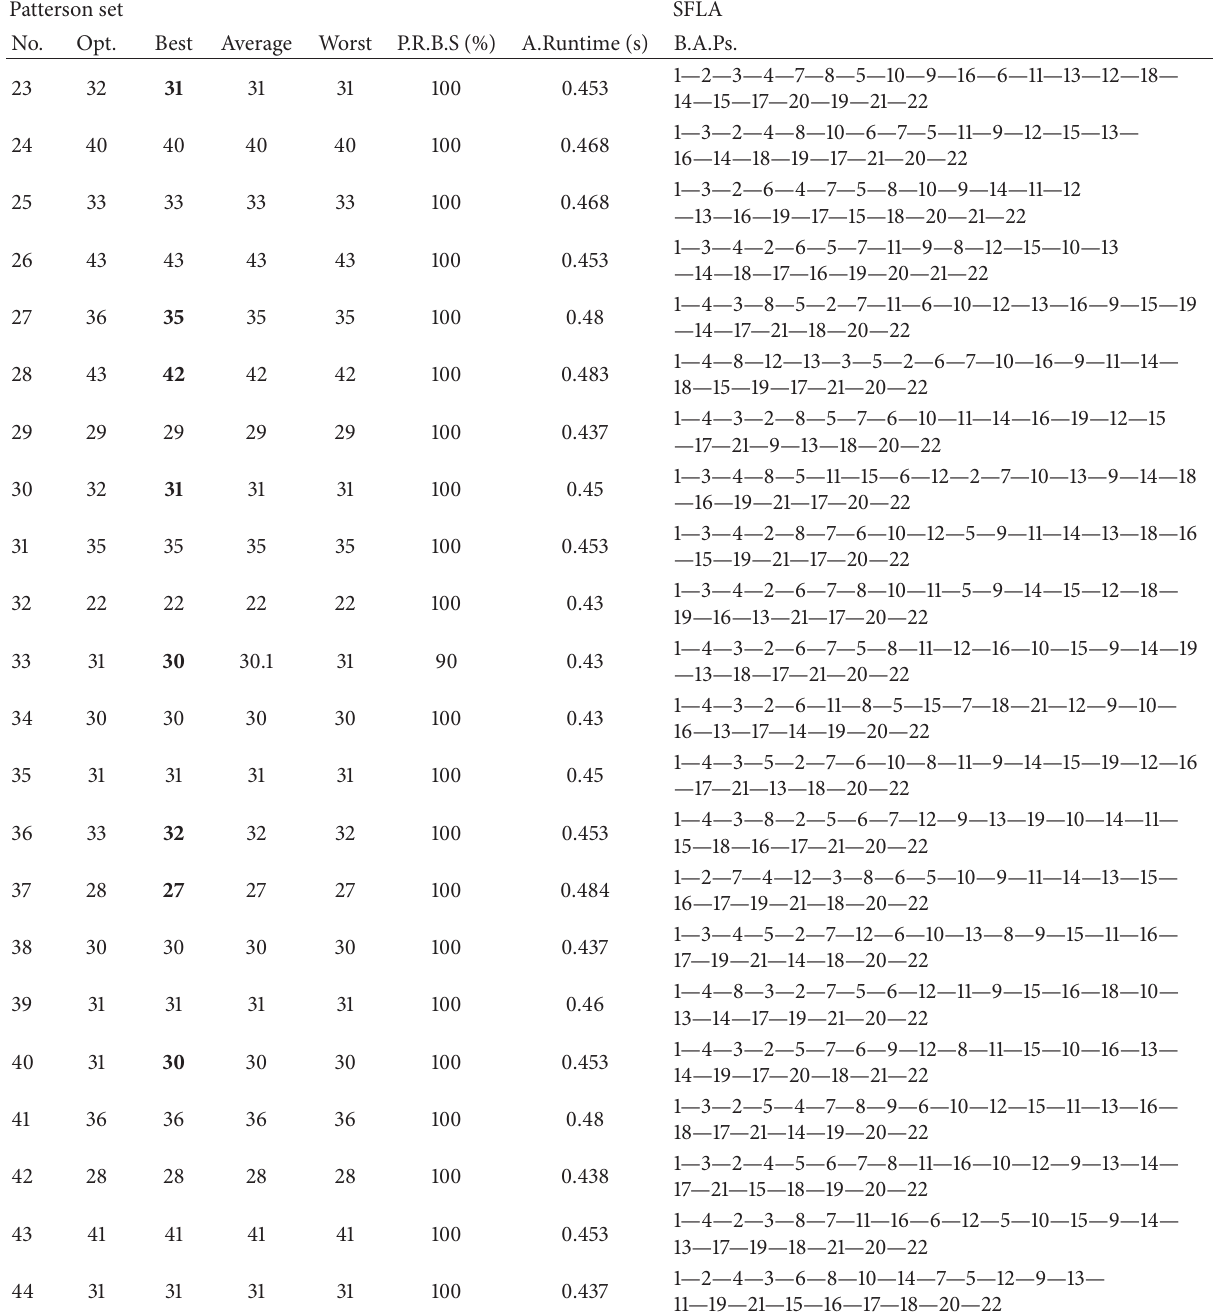
Table 2: Computational results of RCPSP PA SFLA for Patterson set